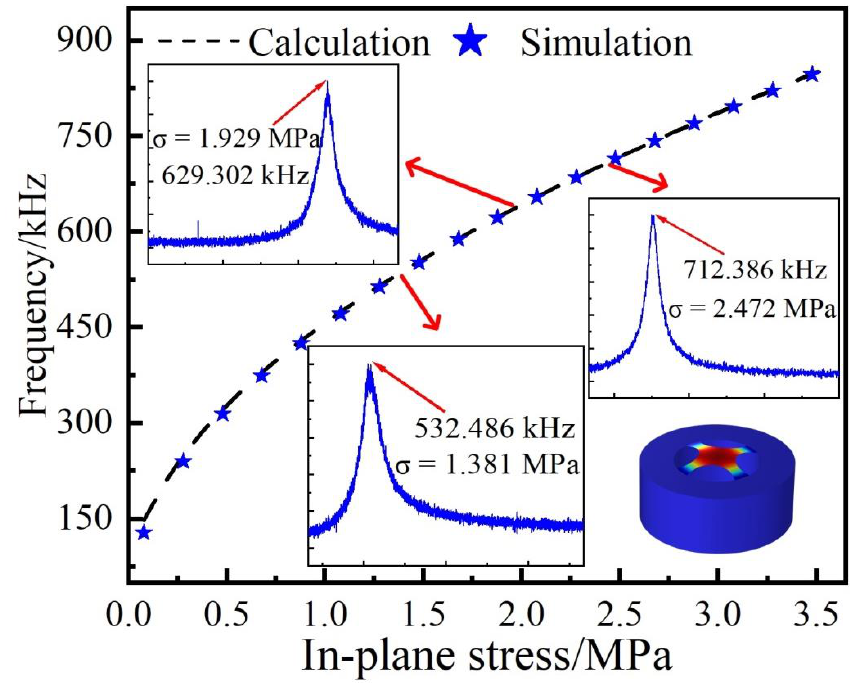
Figure 4. The frequency–stress relationships obtained from COMSOL simulations and calculations, respectively.